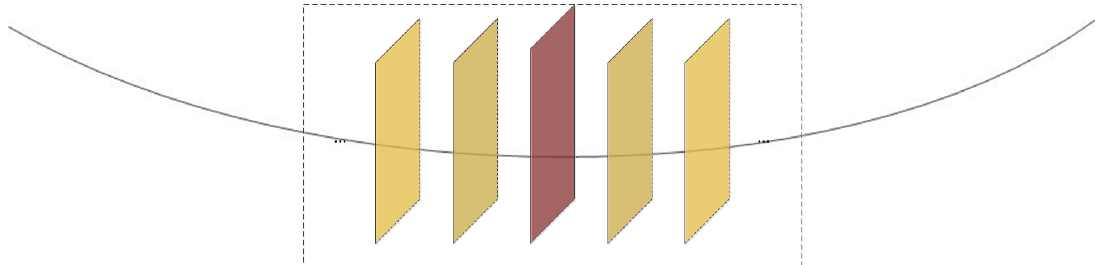
Figure 3. A main profile matches with many others within a range (indicated using the rectangle of dotted lines). The main profile is displayed with red plane, other matched profiles are displayed with yellow planes. yellow planes.